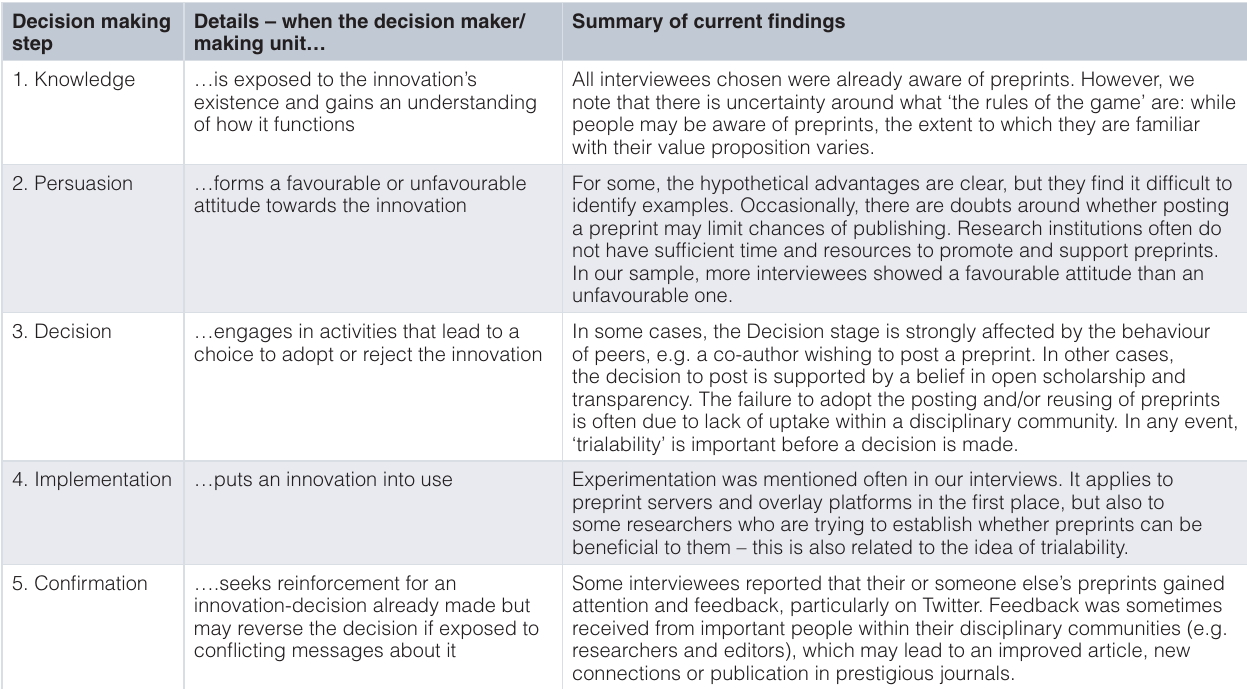
Table 7. Findings in relation to innovation adoption decision making factors from innovation diffusion theory. Decision making